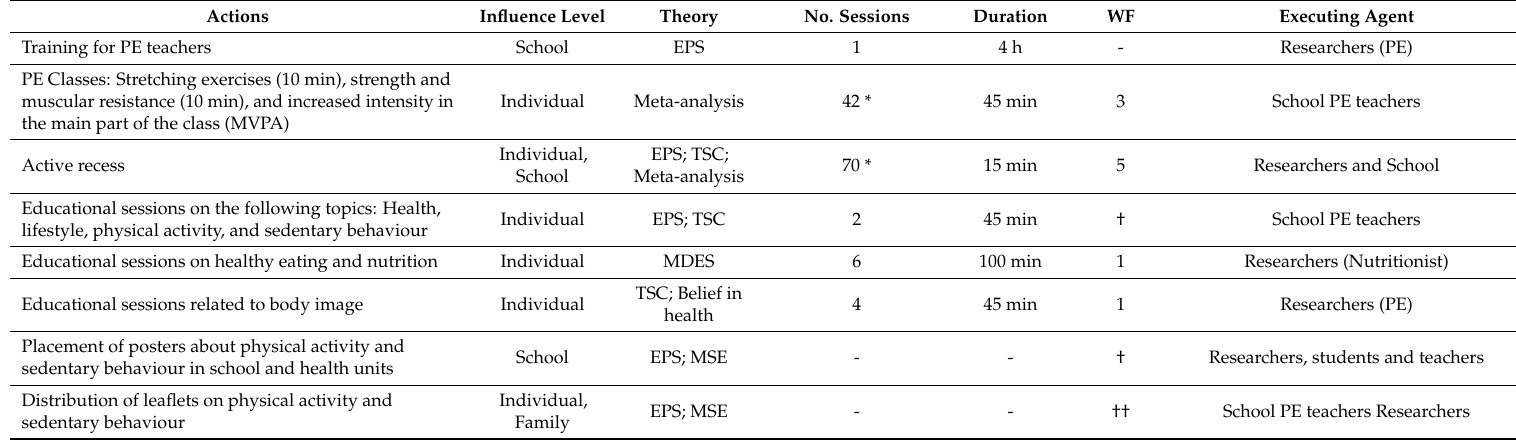
Table 1. Description of “ MEXA-SE ”